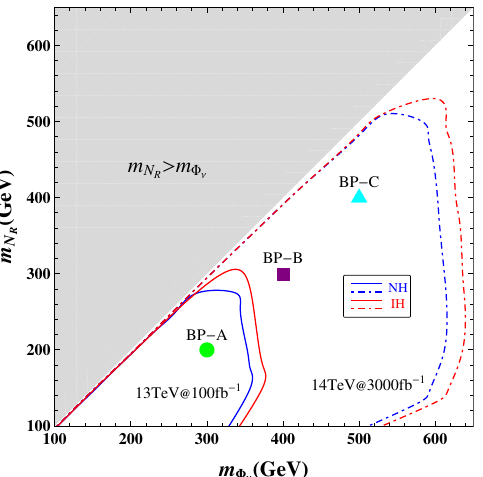
Figure 15 . Same as (cid:12)gure 12, but for the SST